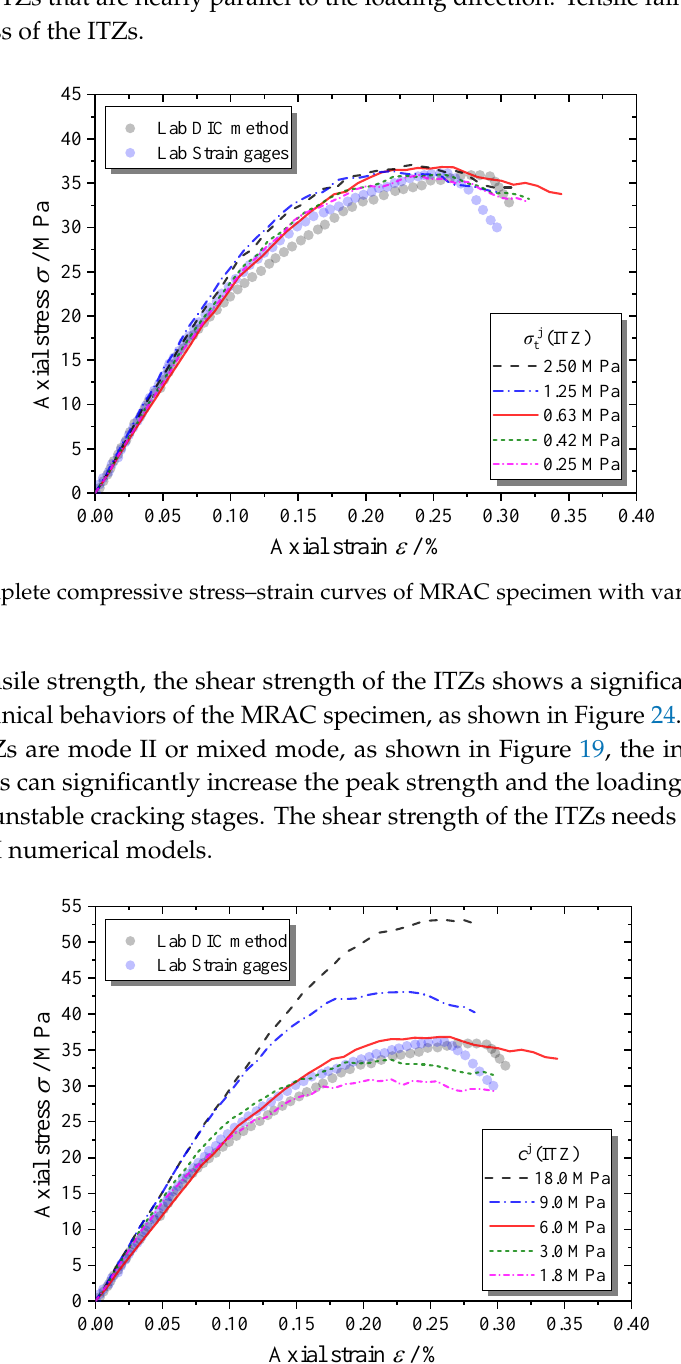
Figure 22. Complete compressive stress–strain curves of MRAC specimen with various ITZ stiffness values.